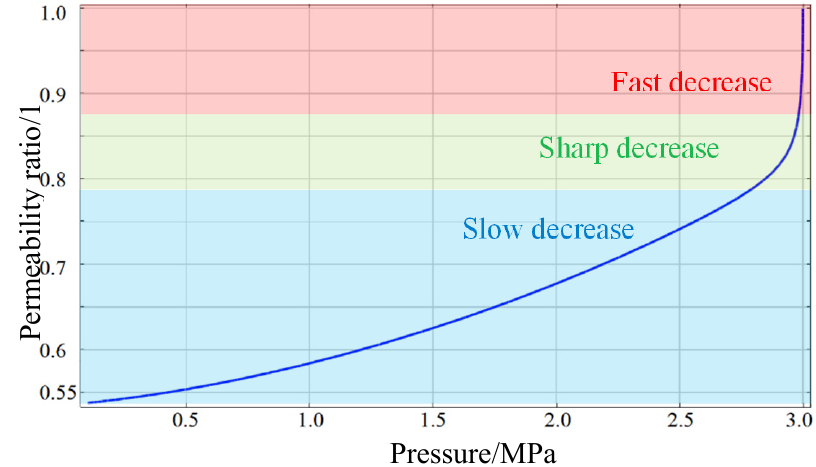
Figure 12. Permeability change for Anderson coal under drainage condition.